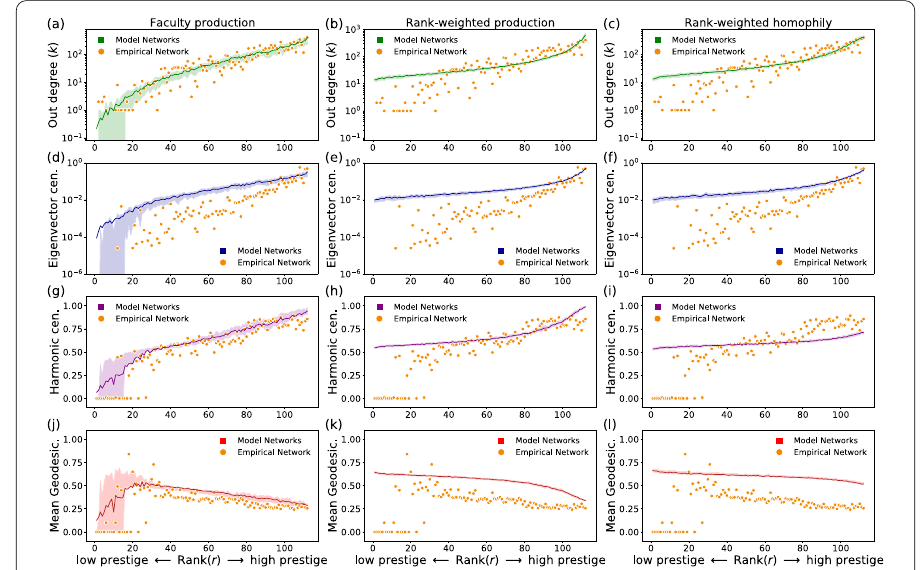
Figure S4 Structural patterns of hiring model networks for three mechanisms of Faculty production, Rank-weighted production, Rank-weighted homophily and the empirical Business hiring network as a function of prestige. ( a ), ( b ), ( c ) Out-degree k i , ( d ), ( e ), ( f ) eigenvector centrality, ( g ), ( h ), ( i ) harmonic centrality, and ( j ), ( k ), ( l ) mean geodesic distance normalized by network diameter. Panels on the left ( a ), ( d ), ( g ), ( j ) show results for the Faculty production model, and panels on the middle ( b ), ( e ), ( h ), ( k ) show results for the Rank-weighted production model. Panels on the right ( c ), ( f ), ( i ), ( l ) show results for the Rank-weighted homophily model. All models simulated with egalitarian initialization. Solid lines indicate the mean over 50 simulations, and shaded region around the mean indicates the 25% to 75% quantile range. Orange points indicate the observed values for the Business hiring network. Large rank denotes higher prestige